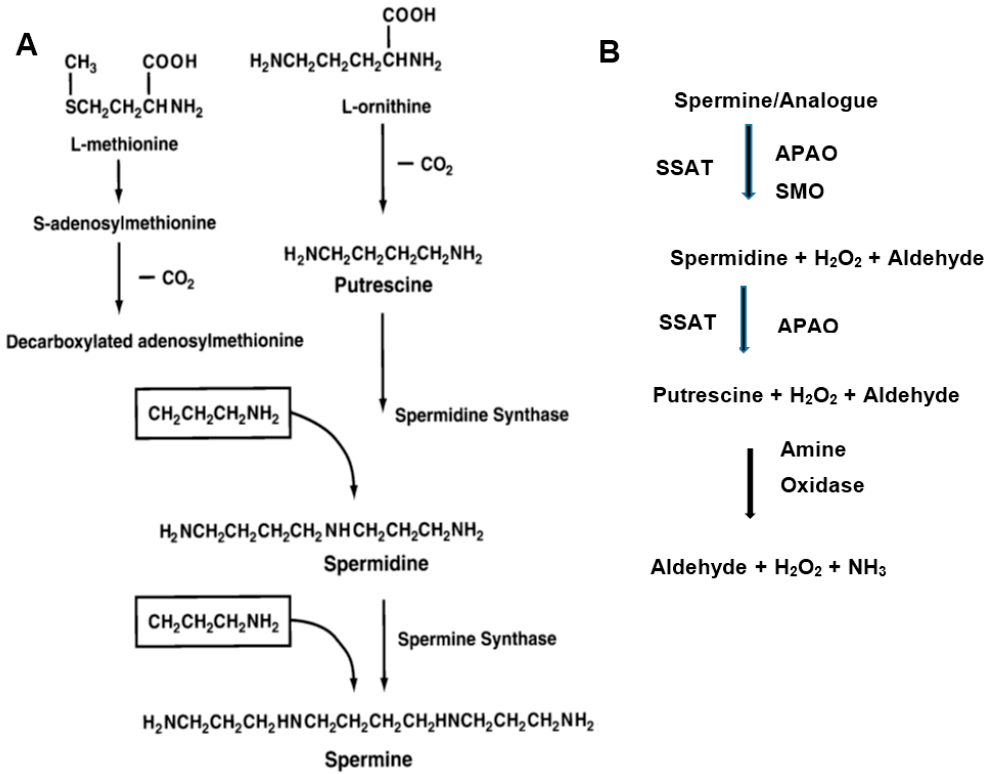
Figure 1. Schematic representation of the polyamine biosynthetic ( A ) and catabolic ( B ) pathways. ( A ) Putrescine is formed by the decarboxylation of ornithine by ornithine decarboxylate (ODC). Spermidine is formed by the action of spermidine synthase that links putrescine to an aminopropyl group derived from decarboxylated S-adenosylmethionine, a reaction product of AdoMetDC. Spermine is synthesized from spermidine by a similar process by spermine synthase. ( B ) Spermine and spermidine are first acetylated spermidine/spermine N 1 -acetyltransferase (SSAT) and then oxidized by N 1 -acetylpolyamine oxidase (APAO). Spermine oxidase (SMO) degrades unmodified spermine/internalized analogue. H 2 O 2 and 3-aceto-aminopropanal are among the degradation products [17]. Multiple amine oxidases are also involved in the degradation of diamines and polyamines, producing H 2 O 2 and aldehydes [33].